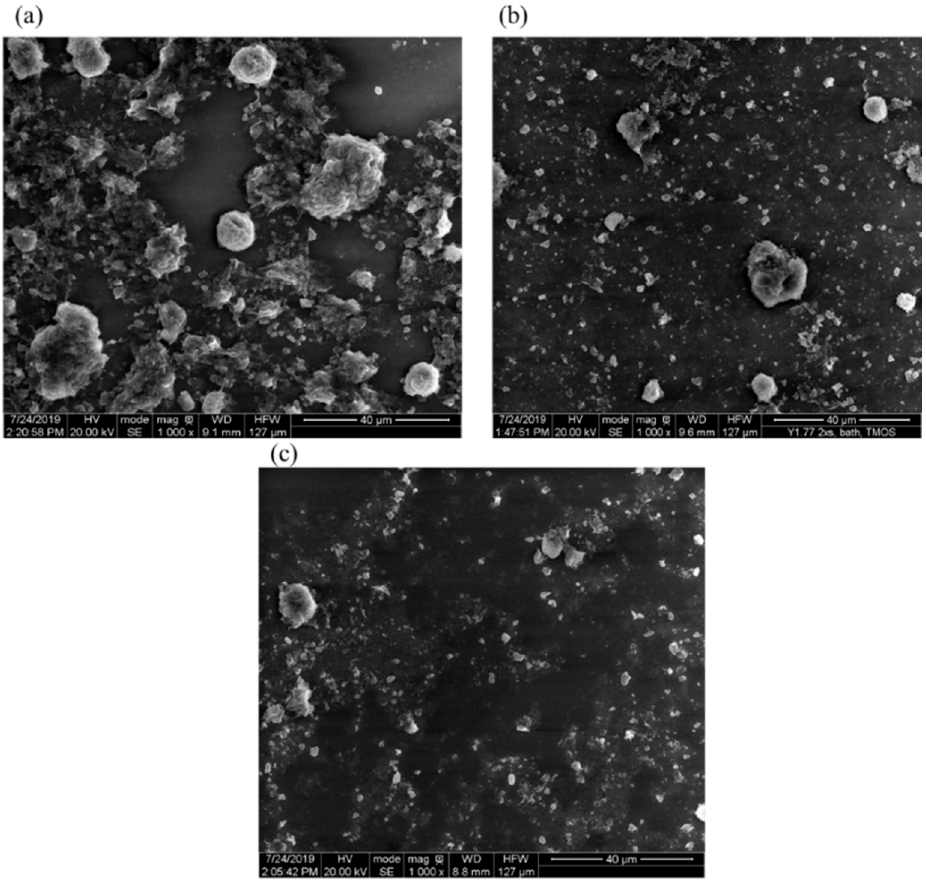
Figure 4. Scanning electron microscopy (SEM) images of dried 1 wt% aqueous dispersions of bentonite nanoclay (NC-Bt)_ in the presence of ( a ) 0 wt%, ( b ) 0.05 wt%, and ( c ) 0.1 wt% CTAB. Scale bar = 40 µm.